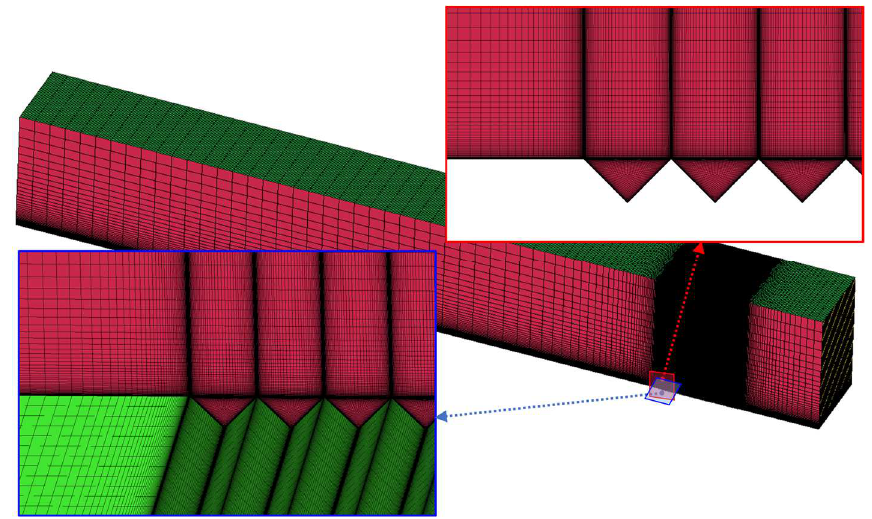
Figure 14. Mesh distribution around transverse V-grooves.